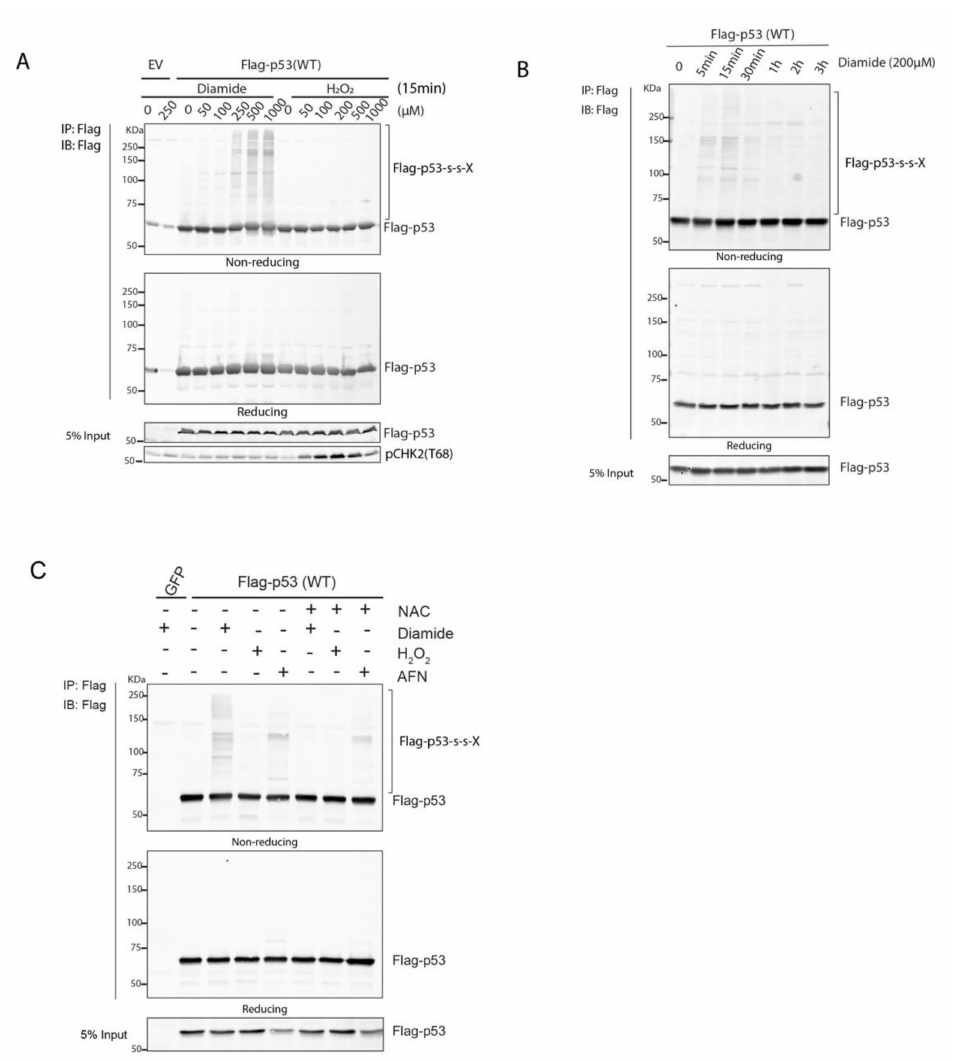
Figure 1. p53 forms redox-sensitive protein–protein interactions upon oxidant treatment. ( A ) Di- amide, but not H 2 O 2 , induces redox-dependent interactions between p53 and other proteins in a dose-dependent manner. Flag-p53 immunoprecipitated from diamide-treated HEK293T cells mi- grates in several high-molecular weight bands under non-reducing conditions. pChk2 levels indicate that H 2 O 2 , but not diamide, induces an ATM-dependent DNA damage response. ( B ) Diamide- induced p53 complexes are reversible and resolved over time by the cellular antioxidant system. ( C ) AFN treatment also induces the formation of p53 complexes, be it with a pattern distinct from diamide. NAC pre-treatment prevents most diamide-induced complex